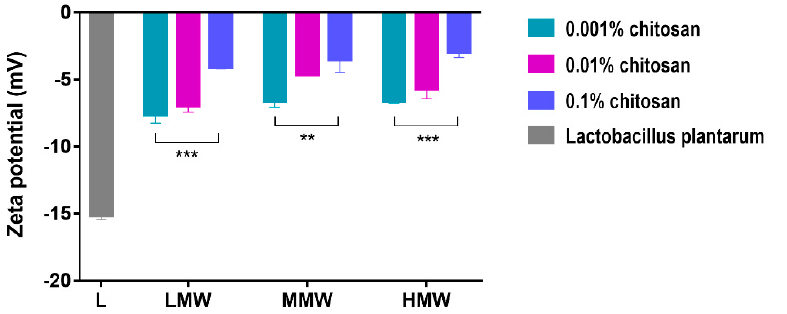
Figure 4. Zeta potential values of untreated (L) Lactobacillus plantarum and 0.001–0.1% LMW, MMW, and HMW chitosan treated bacterium cell surface. Zeta potential showed negative values. The in- vestigation was done in triplicates; data are presented as means ± SD; *** p < 0.001 and ** p < 0.01.